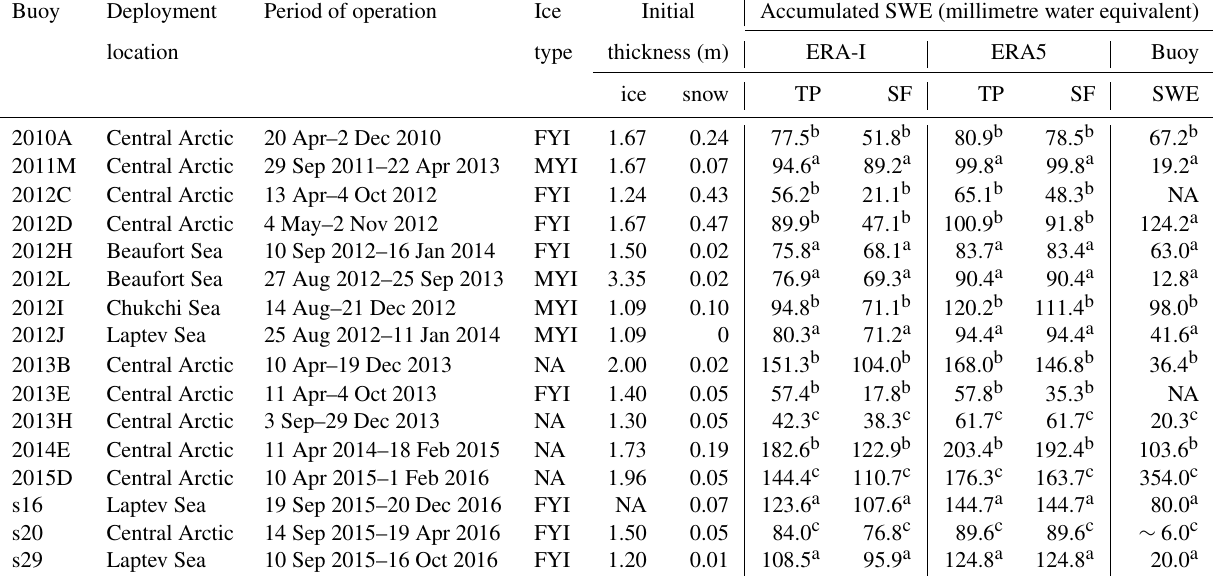
Table 1. Summary of deployment locations and initial conditions for the buoys. The accumulated snow water equivalent (SWE) is given based on ERA-I, ERA5 and buoy data. The cumulative SWE TP is based on total precipitation assuming precipitation falls as snow when T2M is < 0 ◦ C. The cumulative snowfall (SF) is calculated in the same period as for the cumulative TP. The accumulated SWE measured by the buoy is estimated using a climatological monthly mean snow density based on Warren et al. (1999).